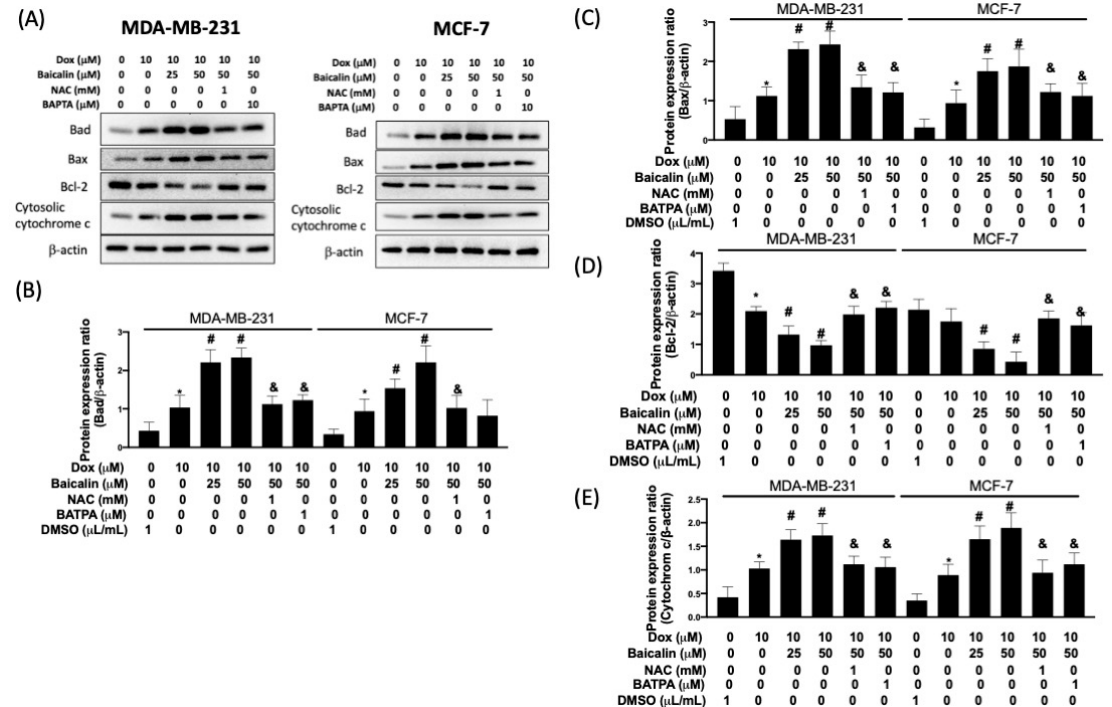
Figure 4. Baicalin promotes Dox-induced apoptosis by mediating the mitochondrial-dependent pathway. Cells were treated with 10 μ M Dox or 10 μ M Dox plus 50 or 25 μ M baicalin for 24 h. In some cells, NAC pretreatment inhibited oxidative stress, whereas BAPTA pretreatment reduced the concentration of intracellular calcium. The expression levels of Bad, Bax, Bcl-2, and cytosolic cytochrome c were investigated using a Western blot assay ( A ). Protein expression levels were quantified and are presented as a bar chart ( B – E ). Data are expressed as the mean ± SEM of three independent analyses; * p < 0.05 versus untreated control, # p < 0.05 versus Dox treatment, & p < 0.05 versus Dox+Baicalin (50 μ M) treat- ment.